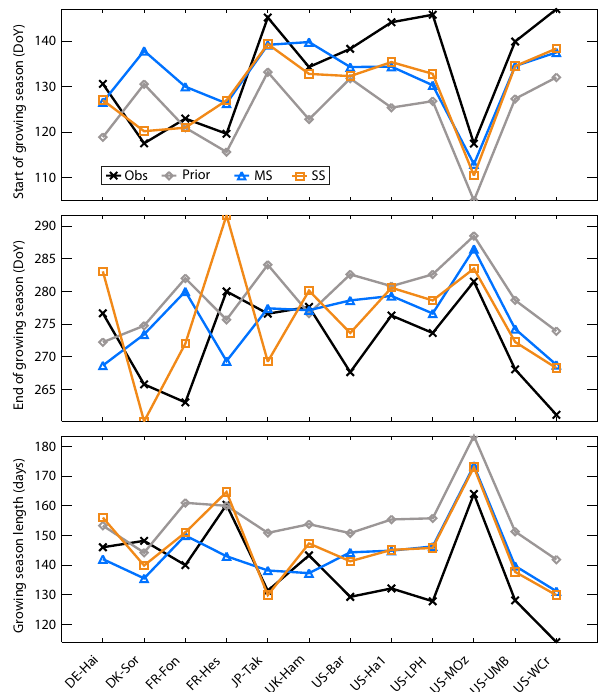
Fig. 5. Starting day, ending day, and length of the growing season (average over all the years available at each site). Measurements are in black, prior model in grey, MS-optimized model in blue, and SS-optimized model in